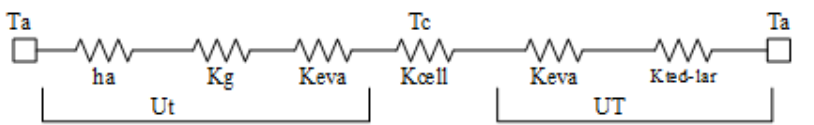
Figure 1. Thermal circuit of a PV panel .